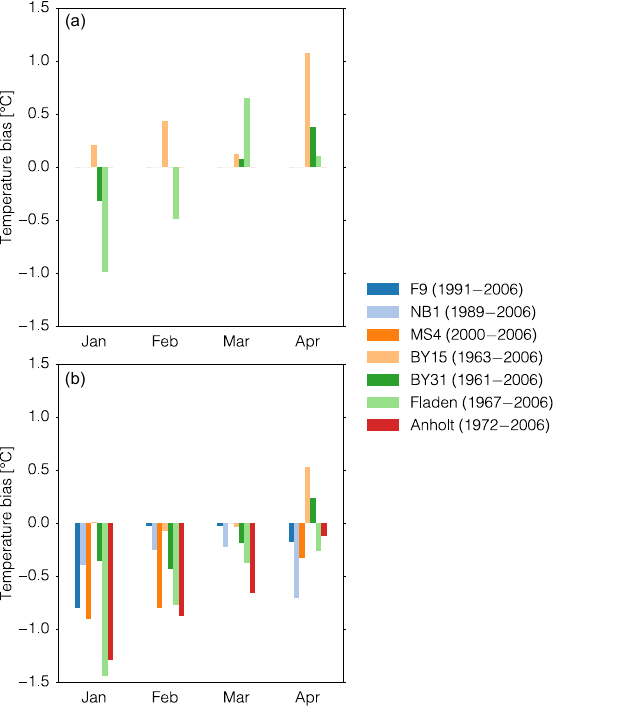
Figure 5. January–April SST biases for a selected number of sta- tions (arranged in north–south order) estimated from CTD casts. The upper panel shows biases for stations available before 1979, and the lower panel after 1979. The full time period of each station is given in the figure legend; for the locations of the different sta- tions, see Fig. 1. Positive values mean that NEMO-Nordic is warmer than the CTD